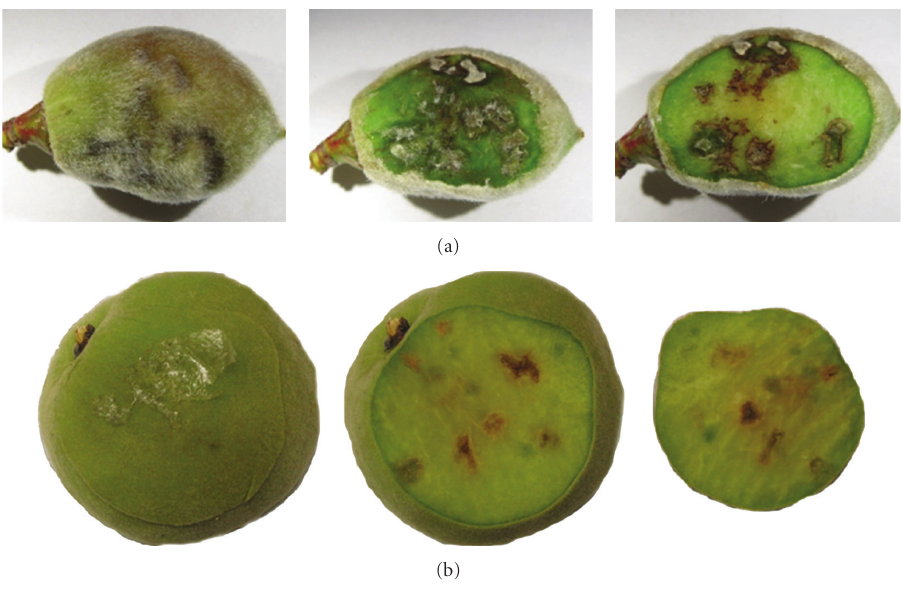
Figure 2: (a) Photos of subsurface corking injury to a 15 mm “Loring” peach in the early season and to (b) a 40 mm “Red Haven” peach ∼ 3 weeks prior to harvest.